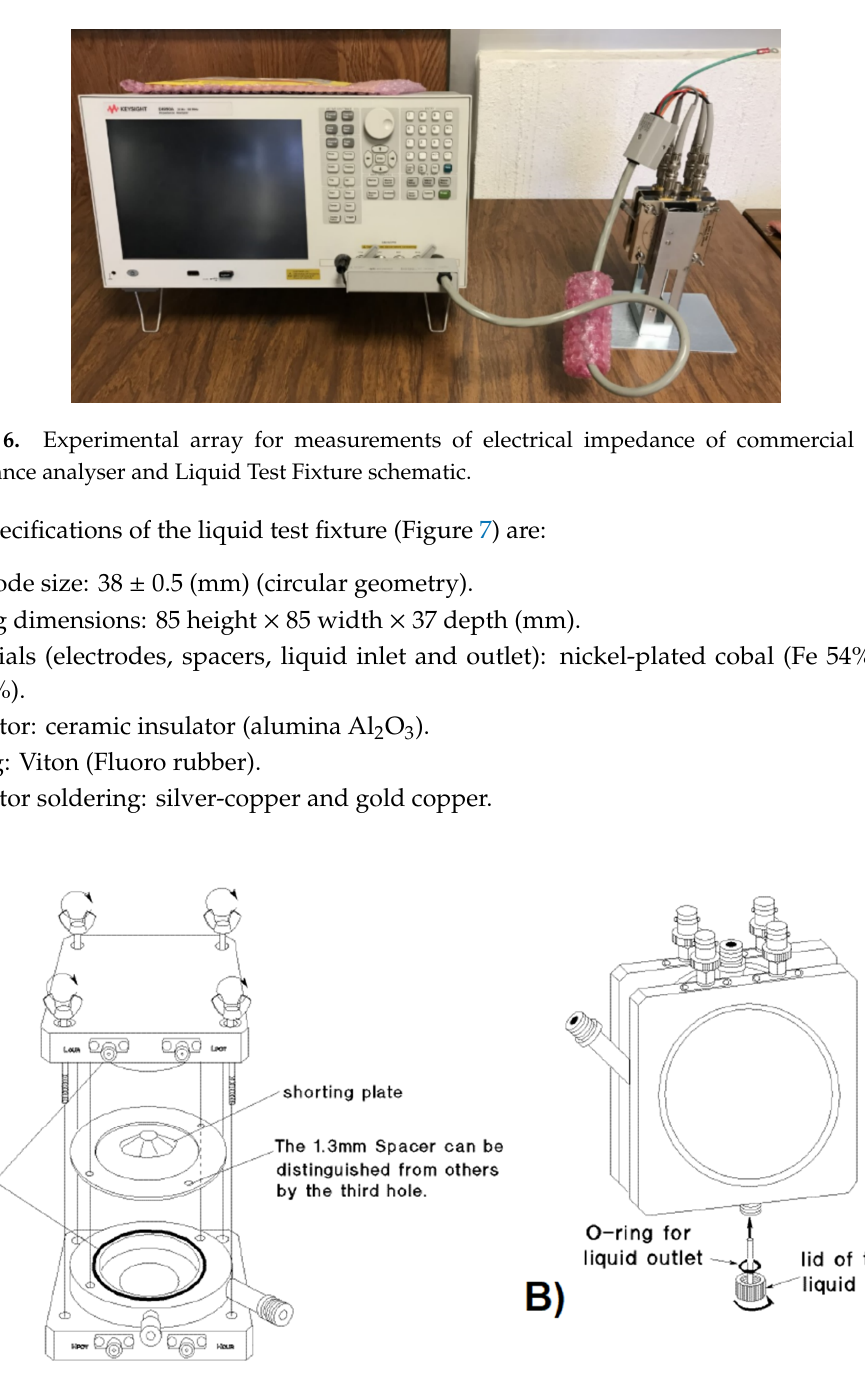
Figure 7. Keysight 16452A liquid test fixture. ( A ) Assembly detail (Short compensation) and ( B ) Assembled liquid test fixture. Reproduced with permission, courtesy of © Keysight Technologies, Inc., 1994–2019.